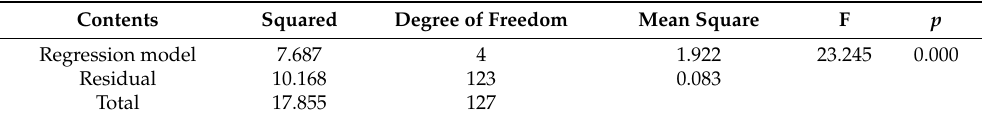
Table 6. Factor of immersion in safety education using VR.